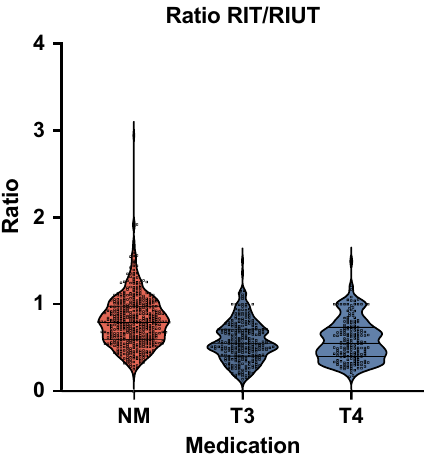
Figure 1. Comparison of the ratio EHL RIT/EHL RIUT in the three investigated